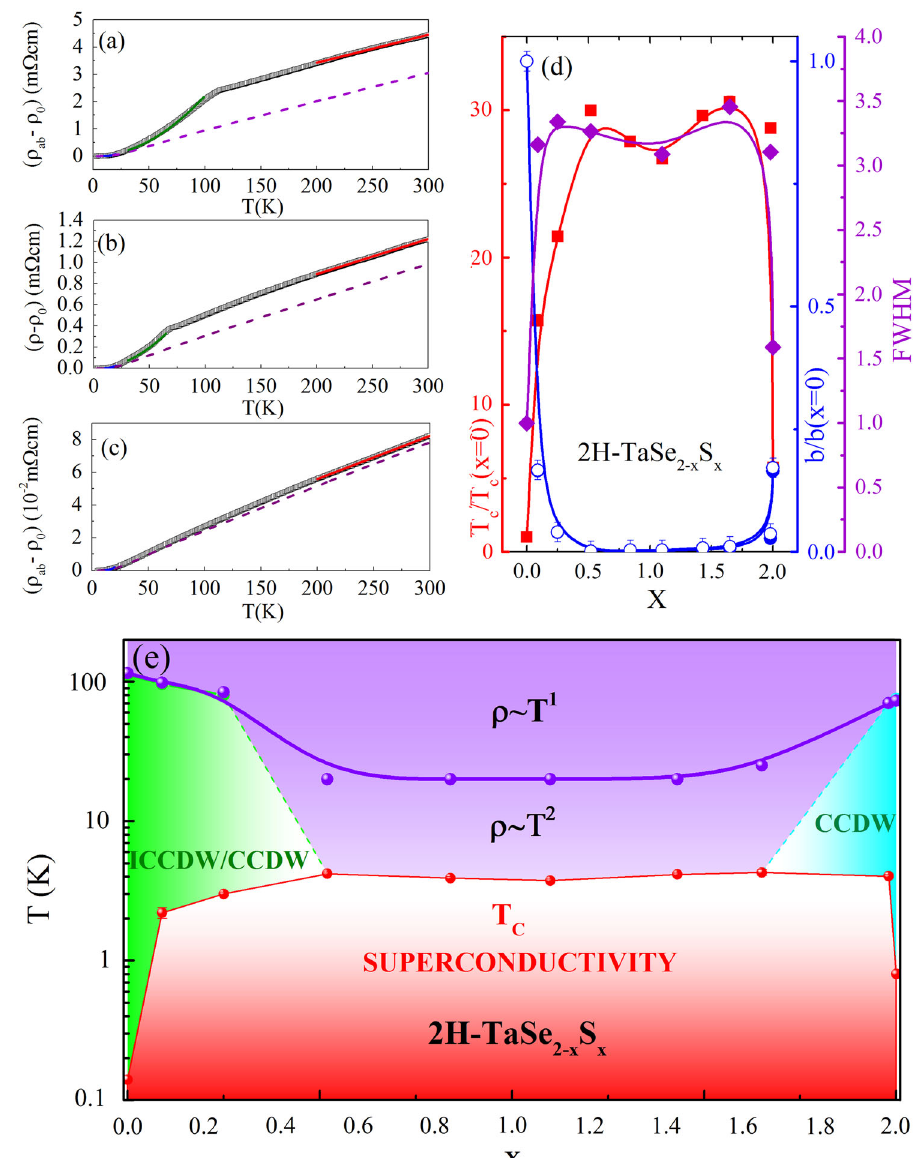
Fig. 4 Electronic phase diagram of 2H-TaSe 2 − x S x (0 ≤ × ≤ 2) a – c Electronic scattering mechanism for a 2H-TaSe 2 , b 2H-TaS 2 , and c 2H- TaSe 0.9 S 1.1 . Low-temperature phonon scattering, scattering of collective excitations of CDW and high-temperature scattering of the local CDW fl uctuations are shown by blue , green , and red solid lines , respectively. Dashed violet line shows the phonon resistivity approximated by the Bloch – Grüneisen formula (see text and Supplementary Information). d Note that the weak double dome evolution of superconducting T c ( x ) coincides with similar evolution of crystallographic disorder with sulfur content as revealed by FWHM of [006] Bragg peak in Fig. 1c. The intensity was normalized to 1 for each value of x . Moreover, T c ( x ) is in close correlation with disorder-induced changes in the high-temperature local charge fl uctuations as seen by the changes in parameter b ; all normalized to values of 2H-TaSe 2 ( x = 0). The parameter b is shown from fi ts without ( open ) and with phonon subtraction from Bloch – Grüneisen formula ( full symbols ) (Supplementary Information). The error bars are about 0.01 for x , up to 0.04 for normalized T c , and up to 0.01 for the normalized parameter b and FWHM (also see Table 1). e Phase diagram indicating the evolution of CDW (incommensurate ICCDW and commensurate CCDW) and superconductivity states with the change of